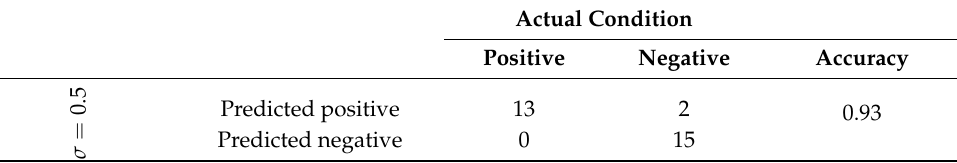
Table 4. Confusion matrix and accuracy of the attack to an AIS/ECDIS setup using the template shown in Figure